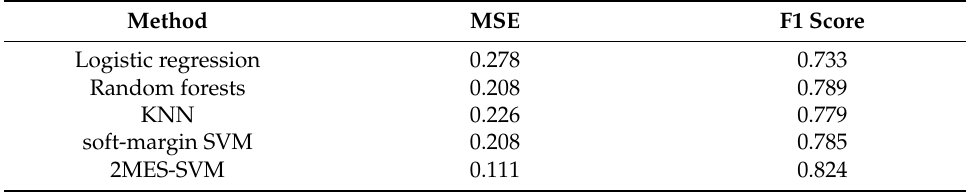
Table 2. The classification performance. Aggregated Cleveland + Statlog